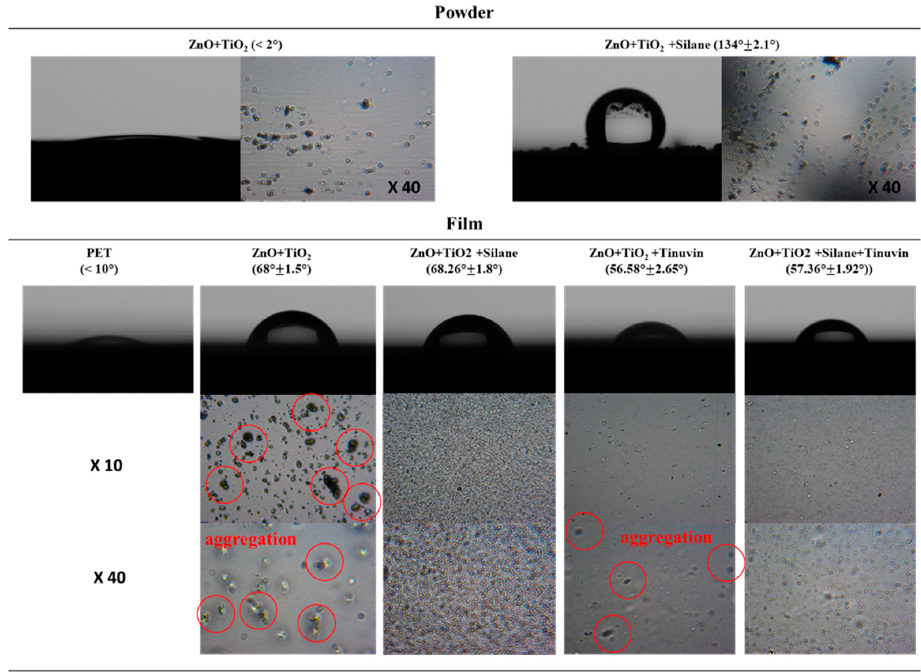
Figure 5. Contact angles and optical microscopy of powders and films with and without silane cou- pling agent . coupling